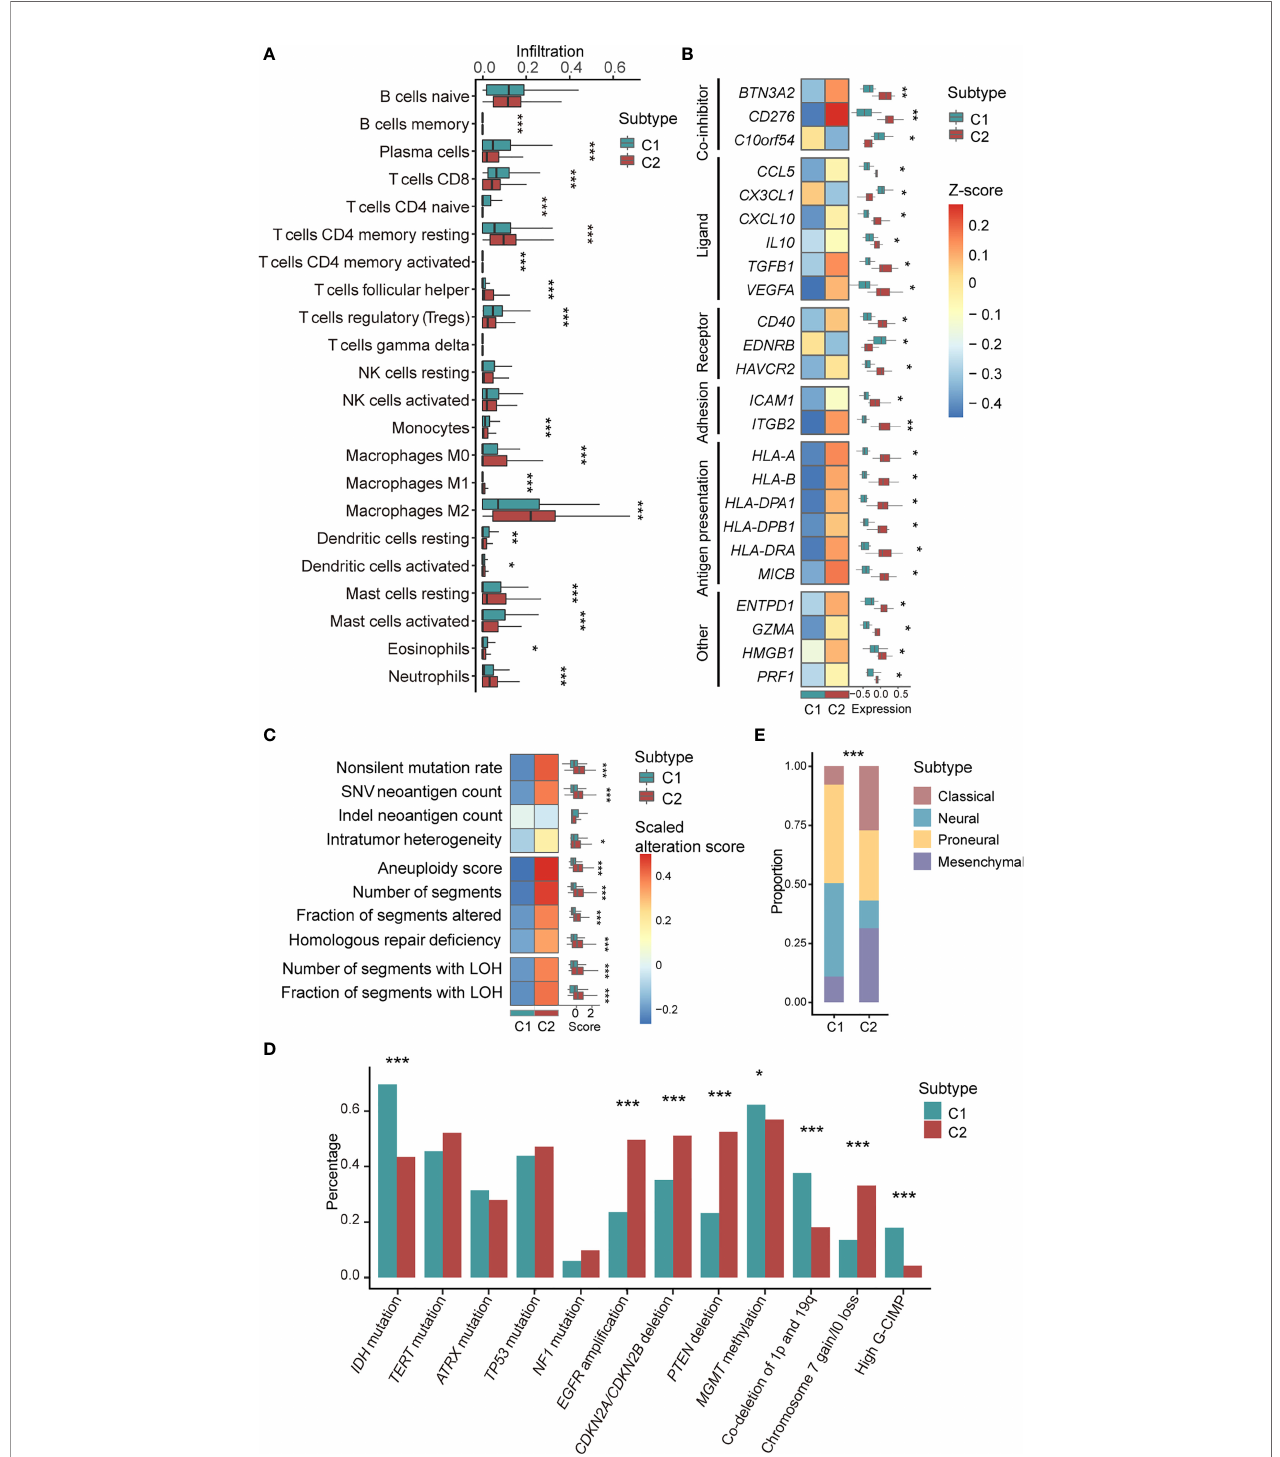
FIGURE 2 | Association between C1/2 subtypes with genomic and transcriptomic signatures. (A) The proportion of in fi ltrated immune cell types in C1 versus C2 subtype. (B) The median expression levels of immunomodulatory genes across 11 brain tumor datasets in C1 versus C2 subtype. (C) Genomic alteration signatures in C1 versus C2 subtype in TCGA low-grade glioma cohort. (D) Alteration prevalence of driver events in C1 versus C2 subtype. (E) The proportion of TCGA molecular subtypes in C1 versus C2 subtype. P values were subjected to multiple hypothesis correction. * P < 0.05, ** P < 0.01, *** P < 0.001. LOH, loss of heterozygosity; G-CIMP, CpG island methylation